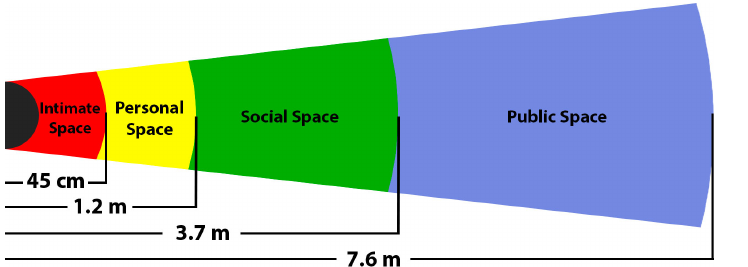
Figure 14. Proxemics theory: different spaces and corresponding distances from a person (in